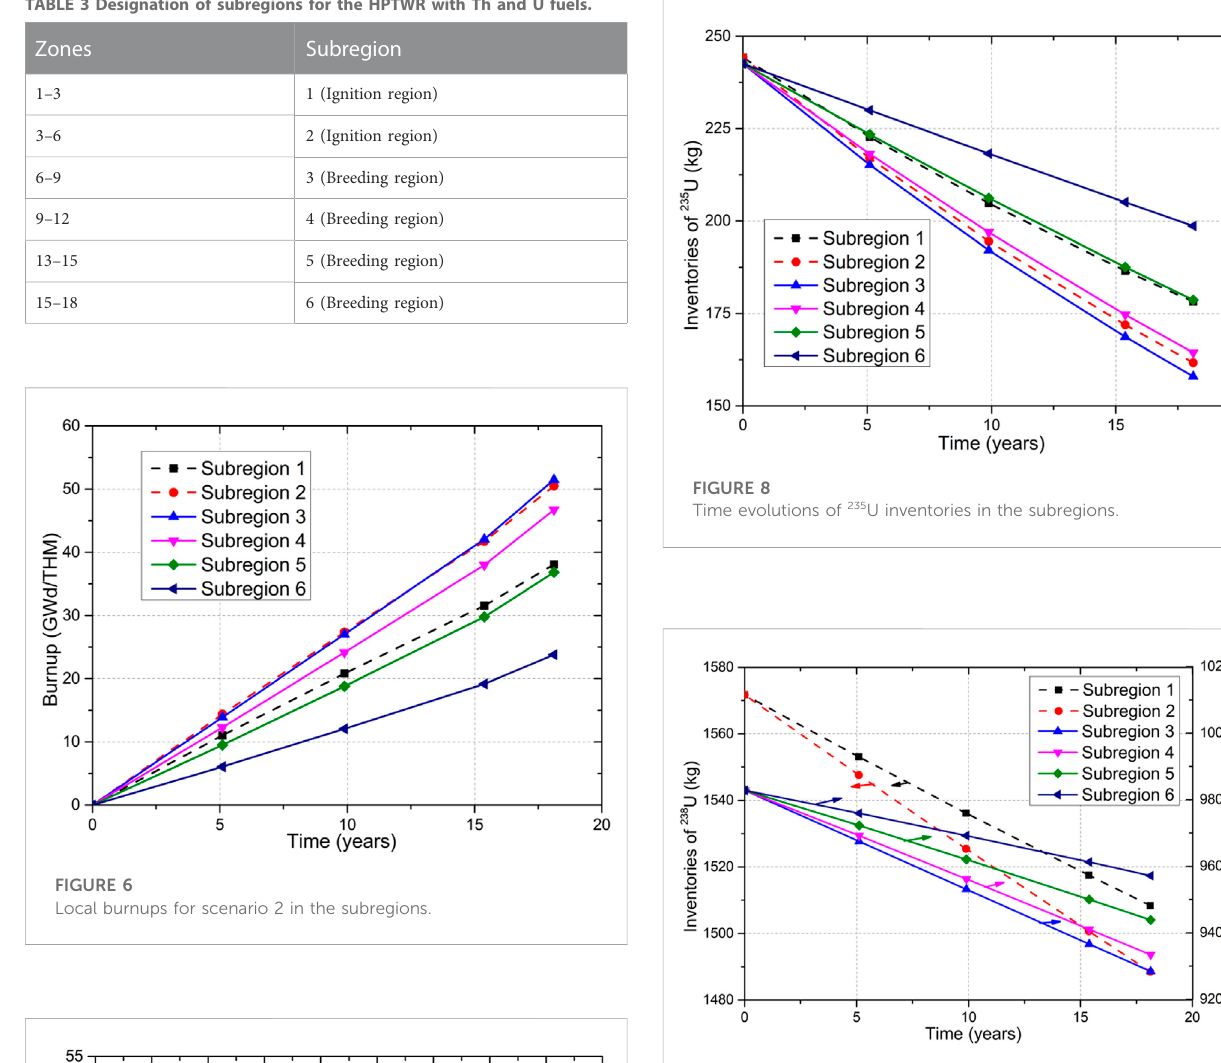
FIGURE 9 Time evolutions of 238 U inventories in the